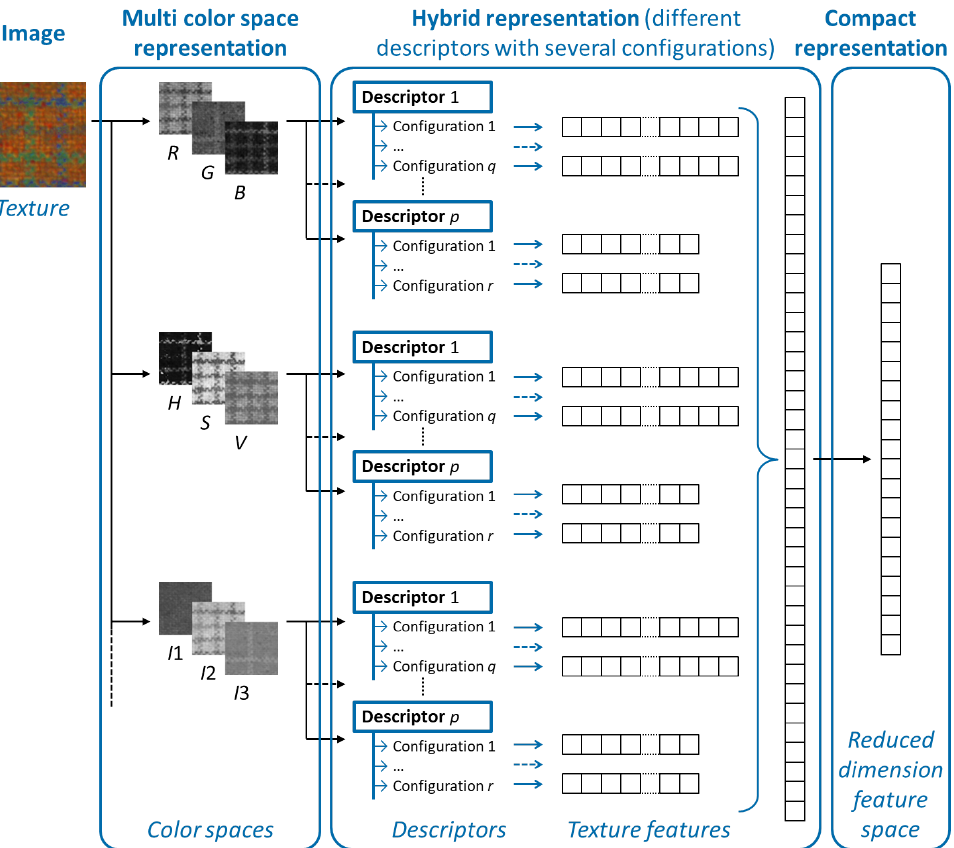
Figure 1. The representation of a texture by the proposed compact hybrid multi-color space descriptor: the image of a color texture is firstly coded in multiple color spaces. Then, several configurations of p descriptors are used to generate a large set of color textures features. Finally, a dimensionality reduction scheme is applied to represent the color